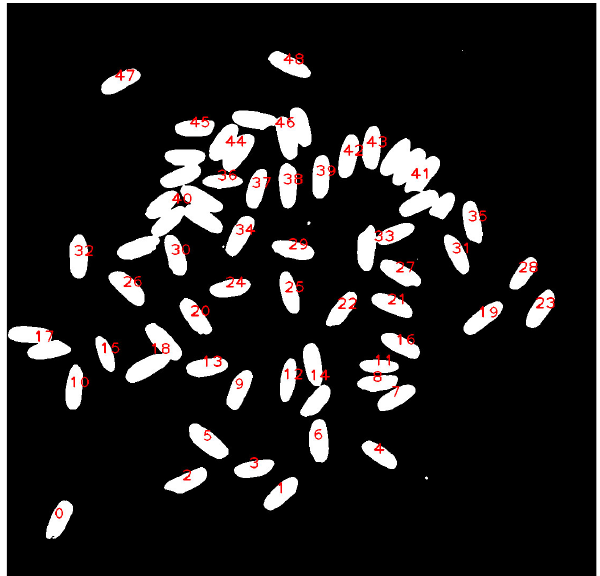
Figure 3. Labeling results of region